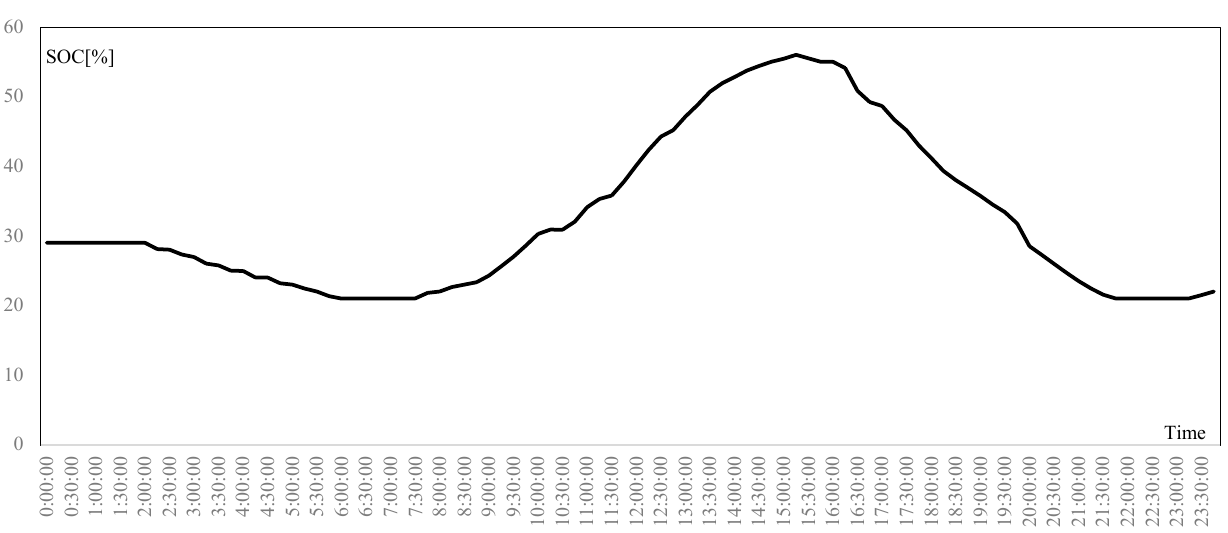
Figure 16. Exchanged power with the grid without the use of the DCNG.